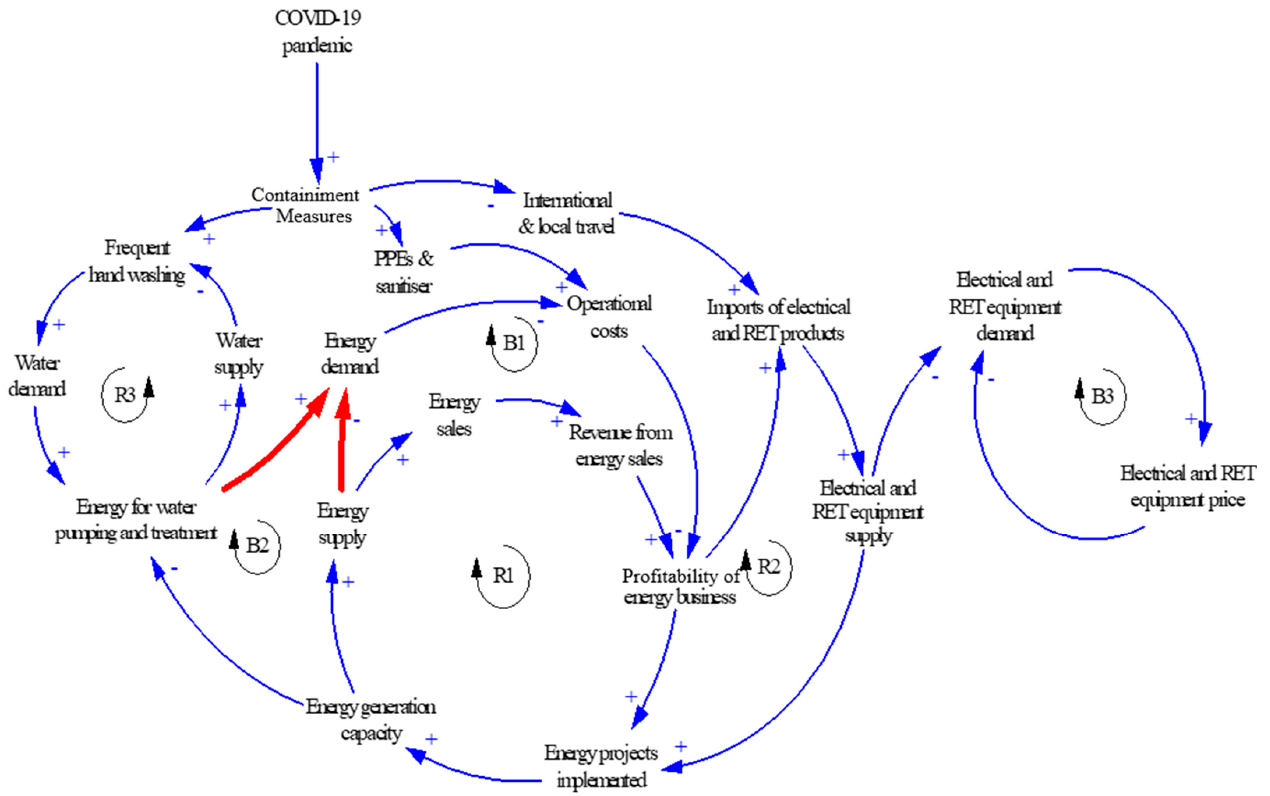
Figure 2. Causal loop diagram of the impacts of COVID-19 pandemic on the energy sector in Malawi. The interconnectedness of the variables is shown, including how they influenced other variables at the arrowhead.